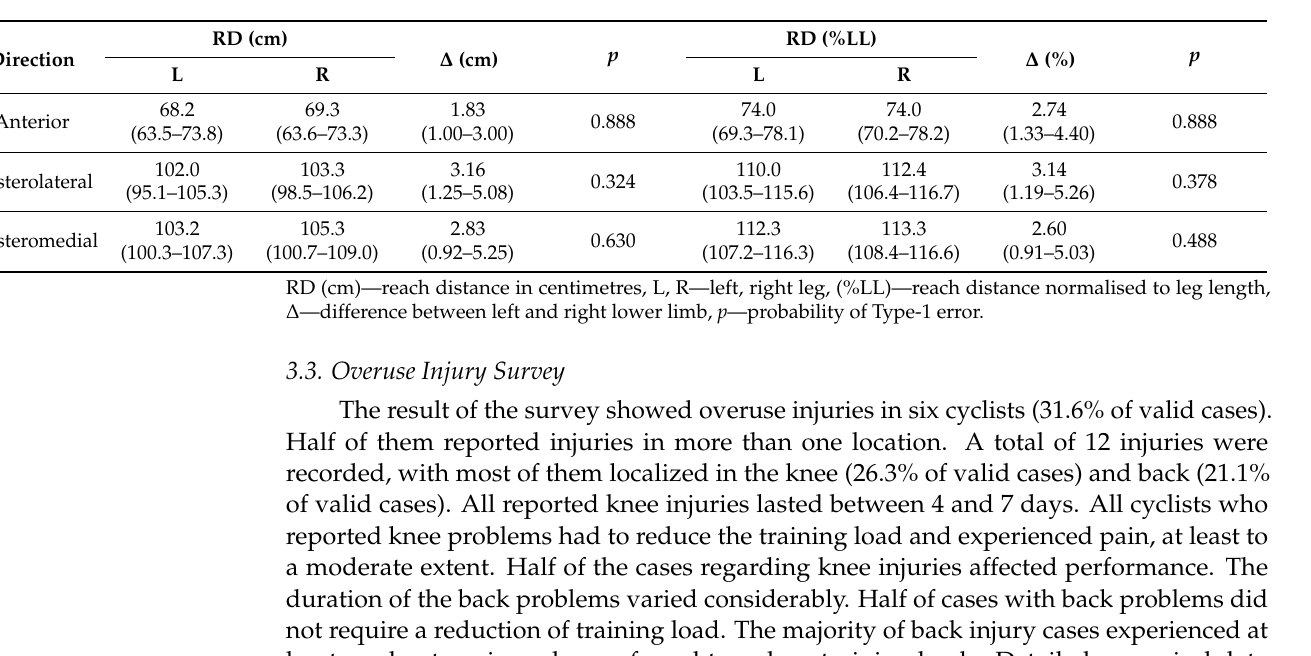
Table 5. Distribution of reach distances (median as well as first and third quartiles) for all directions.